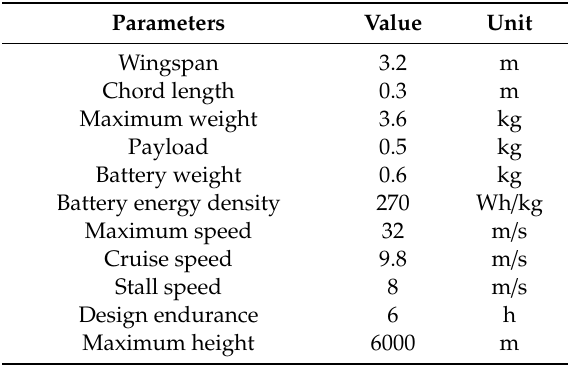
Table 1. Summary of UAV design and performance characteristics.